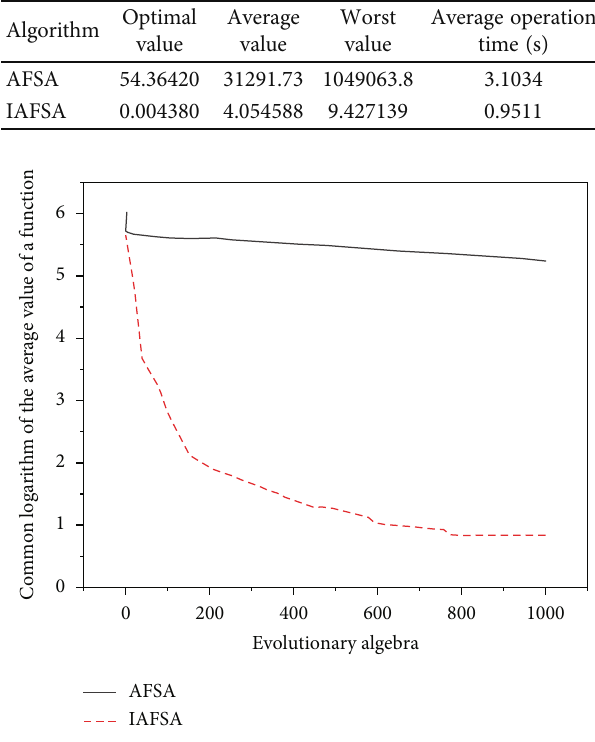
Figure 10: Evolution curve of average optimal value of function f